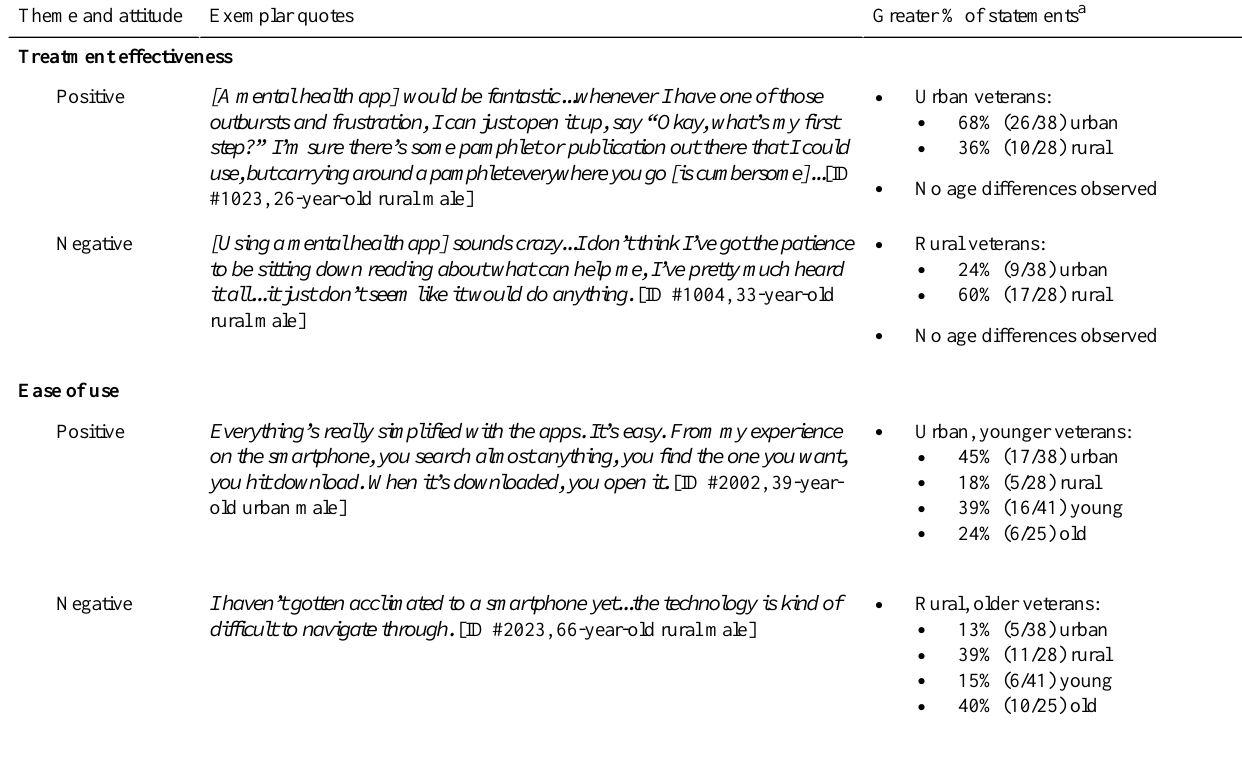
Greater % of statements a Exemplar quotesTheme and attitude